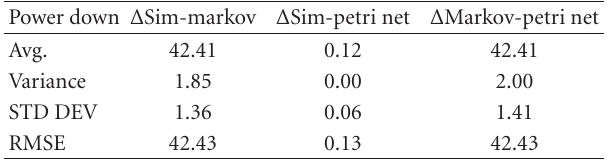
Figure 10: Energy estimates for P ow e r Up De lay = 10 seconds. Table 5: Δ Energy (Joules) estimates ( P ow e r Up De lay = 0 . 3 sec- ond).